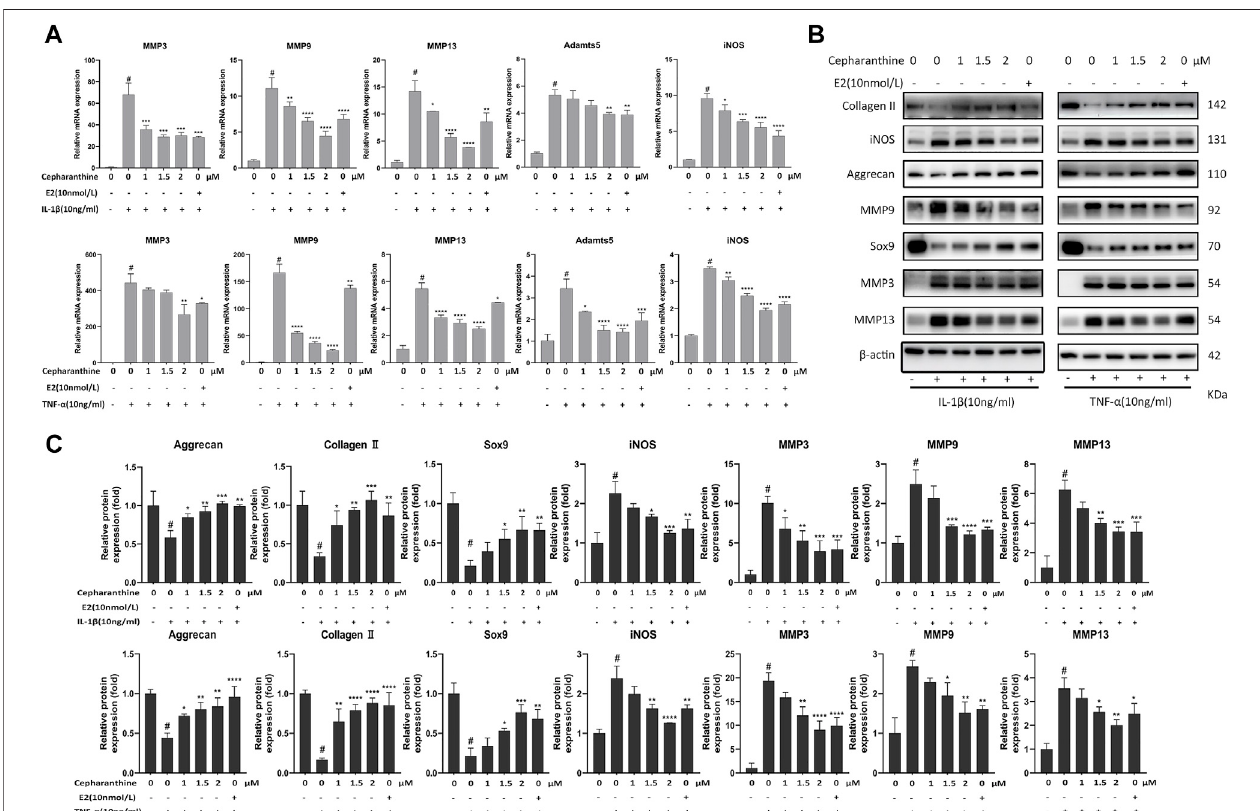
FIGURE 2 | CEP suppressed the expression levels of matrix-degrading genes and in fl ammation-induced cartilage degradation. CEP-pretreated chondrocytes were incubated with IL-1 β or TNF- α at 10 ng/ml for 24 h. (A) Gene expression analysis of MMP3, MMP9, MMP13, Adamts5, and iNOS in mouse chondrocytes treated with IL-1 β or TNF- α . (B,C) Representative Western blots and quanti fi cation data of collagen II, iNOS, aggrecan, MMP9, Sox9, MMP3, and MMP13 in mouse chondrocytesaftertreatmentwithIL-1 β orTNF- α ,respectively.Valuesareexpressedasmean±SD, n =3;# p < 0.05vs.controlgroup,* p < 0.05,** p < 0.01,*** p < 0.001, and **** p < 0.0001 vs. model